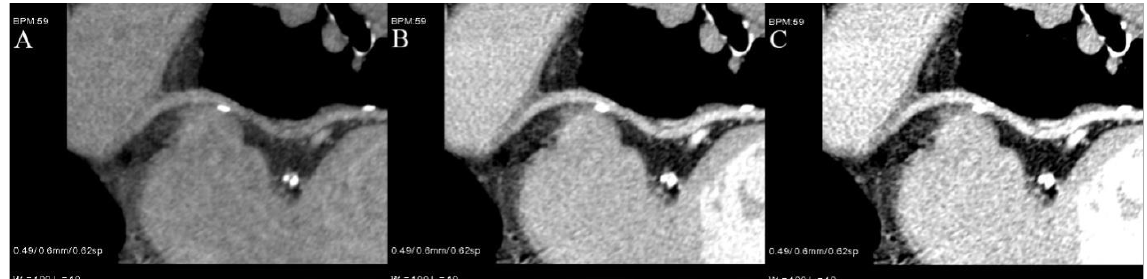
Figure 3. Curved VMI reconstruction of coronary graft of poorly enhanced CTA. Three reconstructions with different energies (( A )—80 kev, ( B )—60 keV, ( C )—50 keV) and the same window and level settings. Contrast density is rising with lower energies, but also noise and artifacts from metal clips around graft.